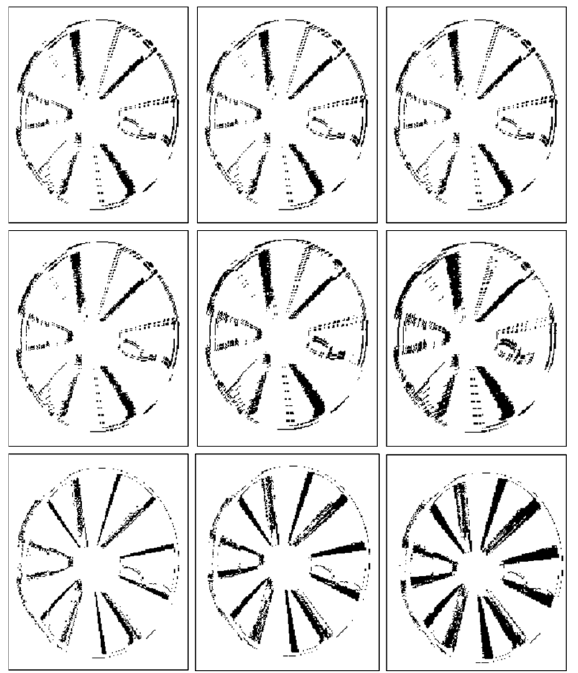
Figure 10. Siemens Star with a 30° rotation from the image plane of the ToF sensor without motion ( top ), with synthetic motion blur ( middle ), with real motion blur ( bottom ) at 60 RPM ( left ), 100 RPM ( center ), and 135 RPM ( right ).